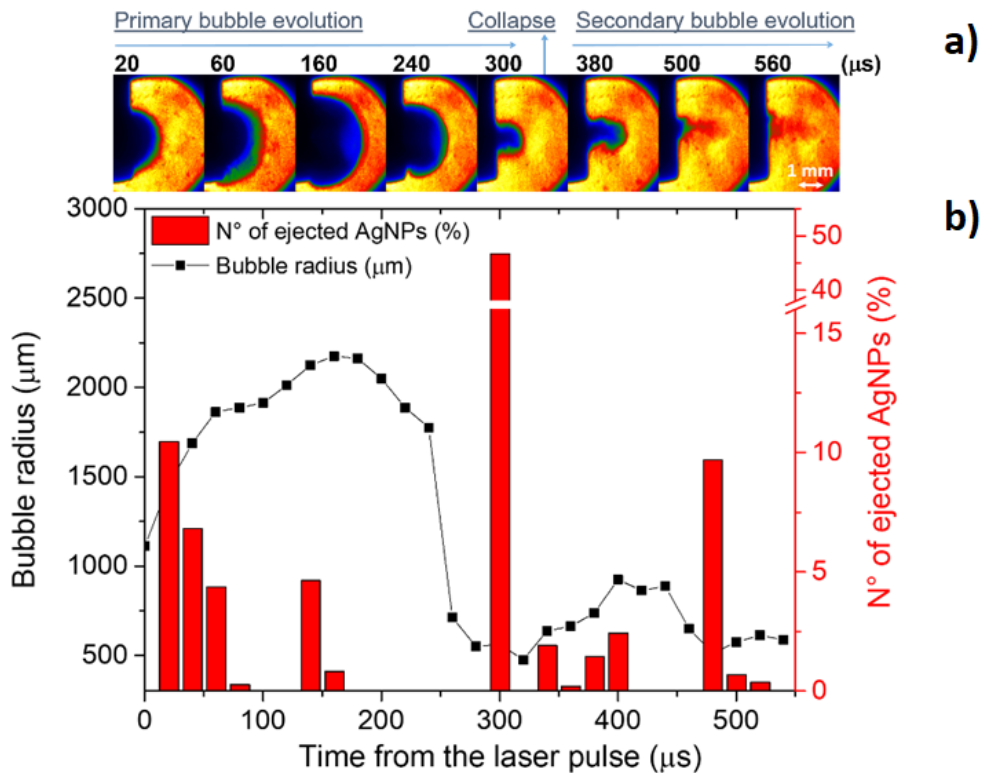
Figure 4. Time resolved shadowgraphy images of the laser induced bubble on Ag target immersed in water ( a ) and the corresponding bubble radius compared with the number of ejected Ag NPs during the bubble evolution (as calculated in [44]) ( b ). Experimental conditions: laser energy = 108 mJ, laser frequency = 2 Hz, laser crater size = 1 ± 0.2 mm, ICCD gate width = 20 µs and 5 accumulations for each image.